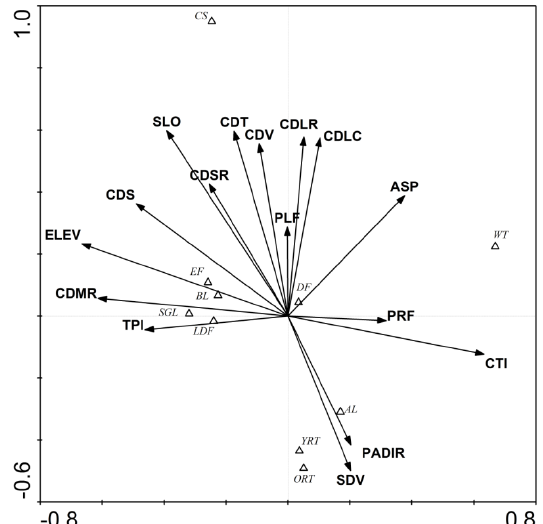
Figure 5. CCA ordination of vegetation classes’ spatial pattern in relation to environmental variables in southern study area. The symbols of vegetation classes are listed in Table 4. The symbols of environmental variables are described in Tables 2 and 3. By projecting the points of the vegetation classes (triangles) onto the arrows of quantitative environmental variable, an approximate ordering of those vegetation classes with respect to that environmental variable can be